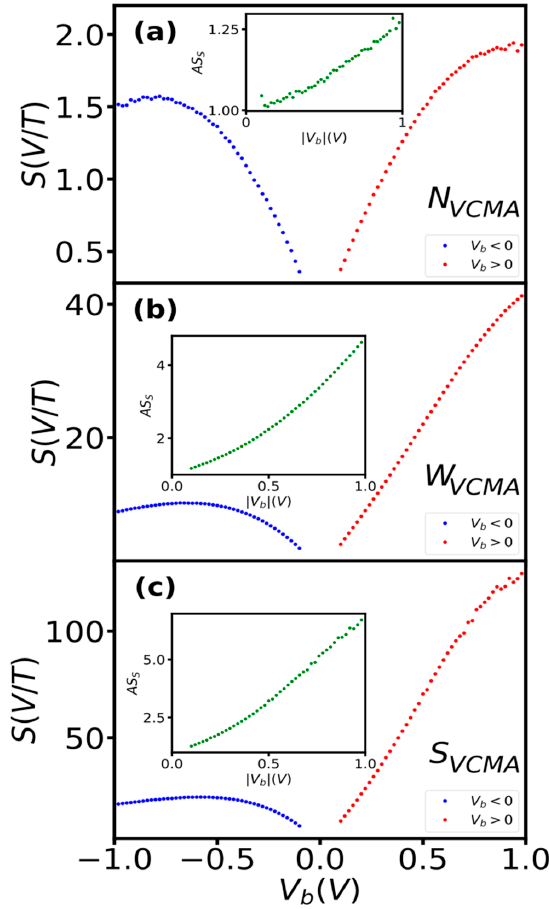
Figure 2. Bias voltage dependence of sensitivity of sensors without ( a ), with medium ( b ) and strong ( c ) VCMA modification. Inset the influence of bias polarity on symmetry of the sensitivity. The asymmetry was computed as AS S = S(+V b )/S( − V b ).